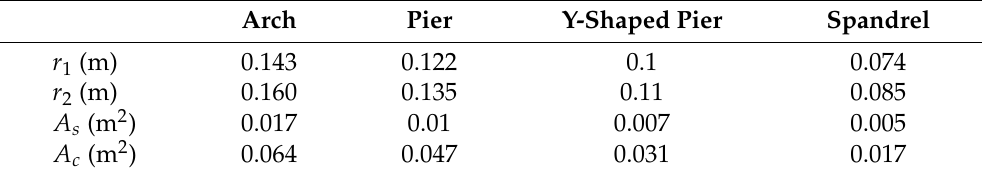
Table 4. Tubular steel cross sections of arch, spandrels and piers [36].